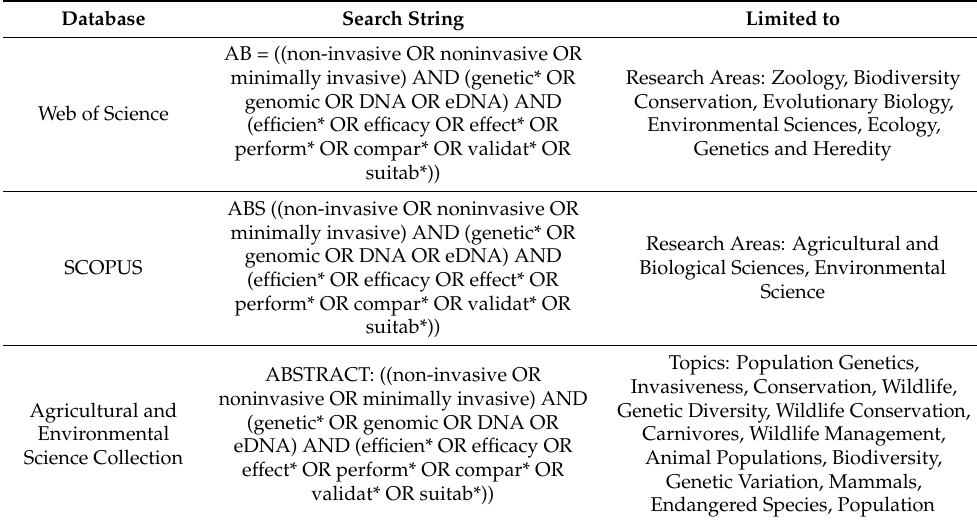
Table 1. Search strings used in each of the three databases. Search results were limited to research areas or topics specific to wildlife research.